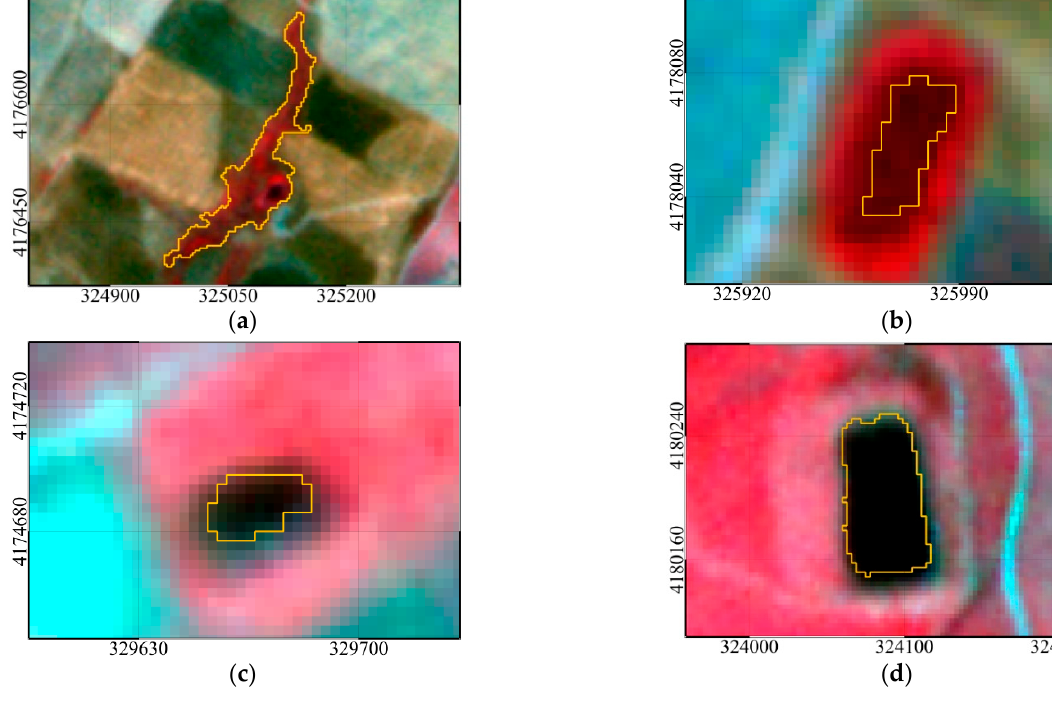
Figure 12. Segmentation or classification issues (yellow line bounded polygons) overimposed to the CIR composition of the images representing the arid and temperate periods (upper and lower panels, respectively): ( a ) erroneous segmentation; ( b and c ) misclassification; ( d ) correct segmentation and classification.